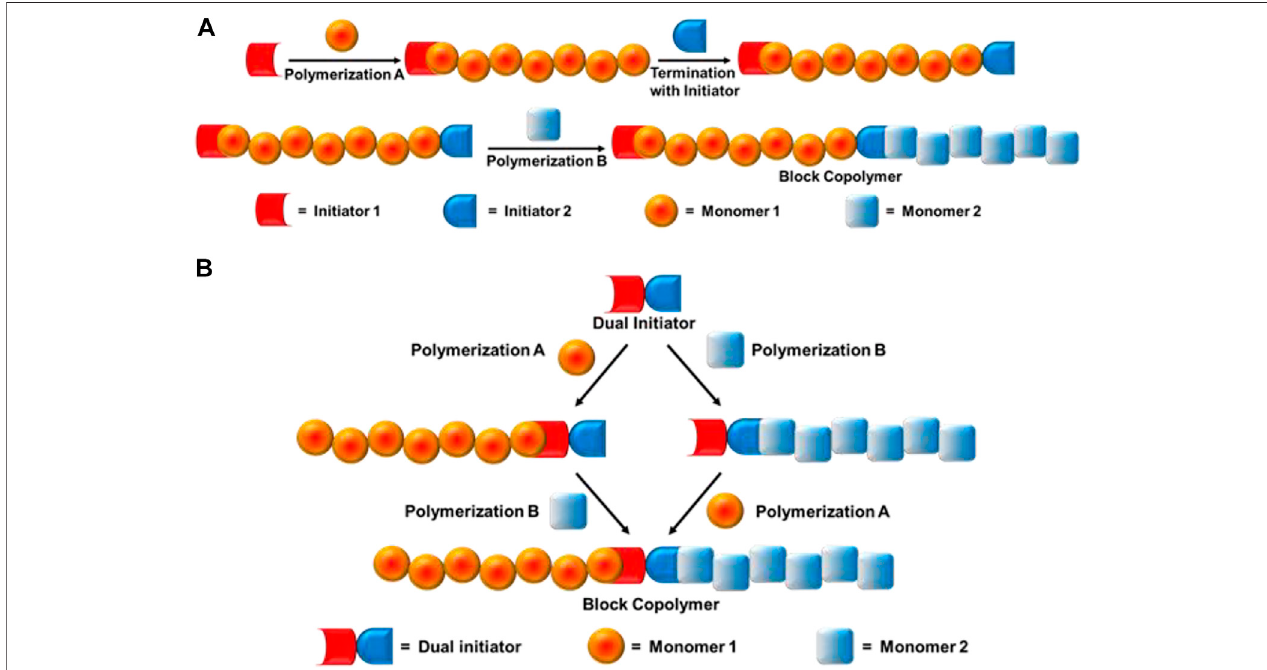
FIGURE 2 | Block copolymer synthesis mechanism: (A) Site transformation method, and (B) dual initiator method.